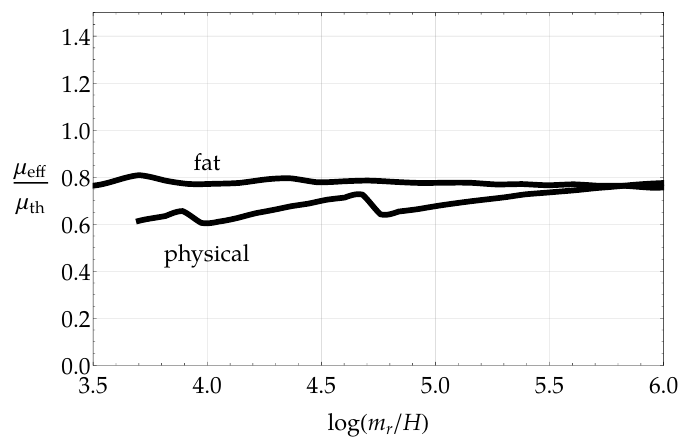
Figure 7 . The closeness of (cid:22) e(cid:11) = t 2 (cid:26) s ( t ) = ( (cid:24) ( t )) to the theoretical prediction (cid:22) th , de(cid:12)ned in eq. (4.18), (plotted in terms of the ratio of these two quantities) is a non-trivial check that our procedure to extract the string energy density (cid:26) s is reliable. More importantly, it shows that the relation eq. (3.2) can be used to predict the energy in the string network for a given string density and time, by replacing (cid:22) e(cid:11) by (cid:22) th , and that the theoretically predicted logarithmic growth in the string tension is seen in simulations.